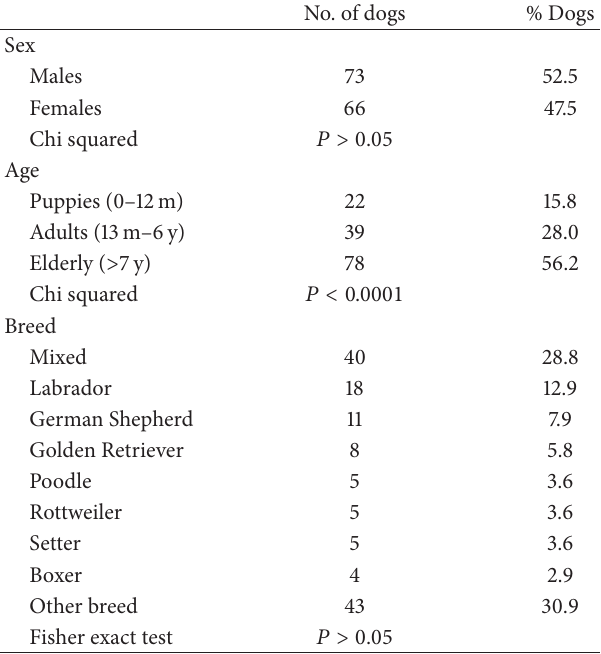
Table 2: Sex, age, and breed of dogs included in the second survey (1,569 dogs—133 dogs with qRBCs = 8.47%) 3,081 CBCs were investigated and 138 CBCs showed qRBCs